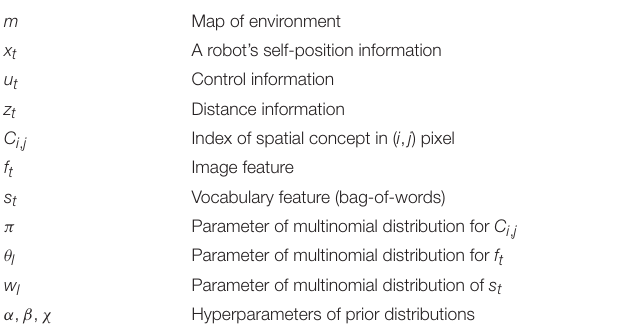
TABLE 1 | Definition of variables in the graphical